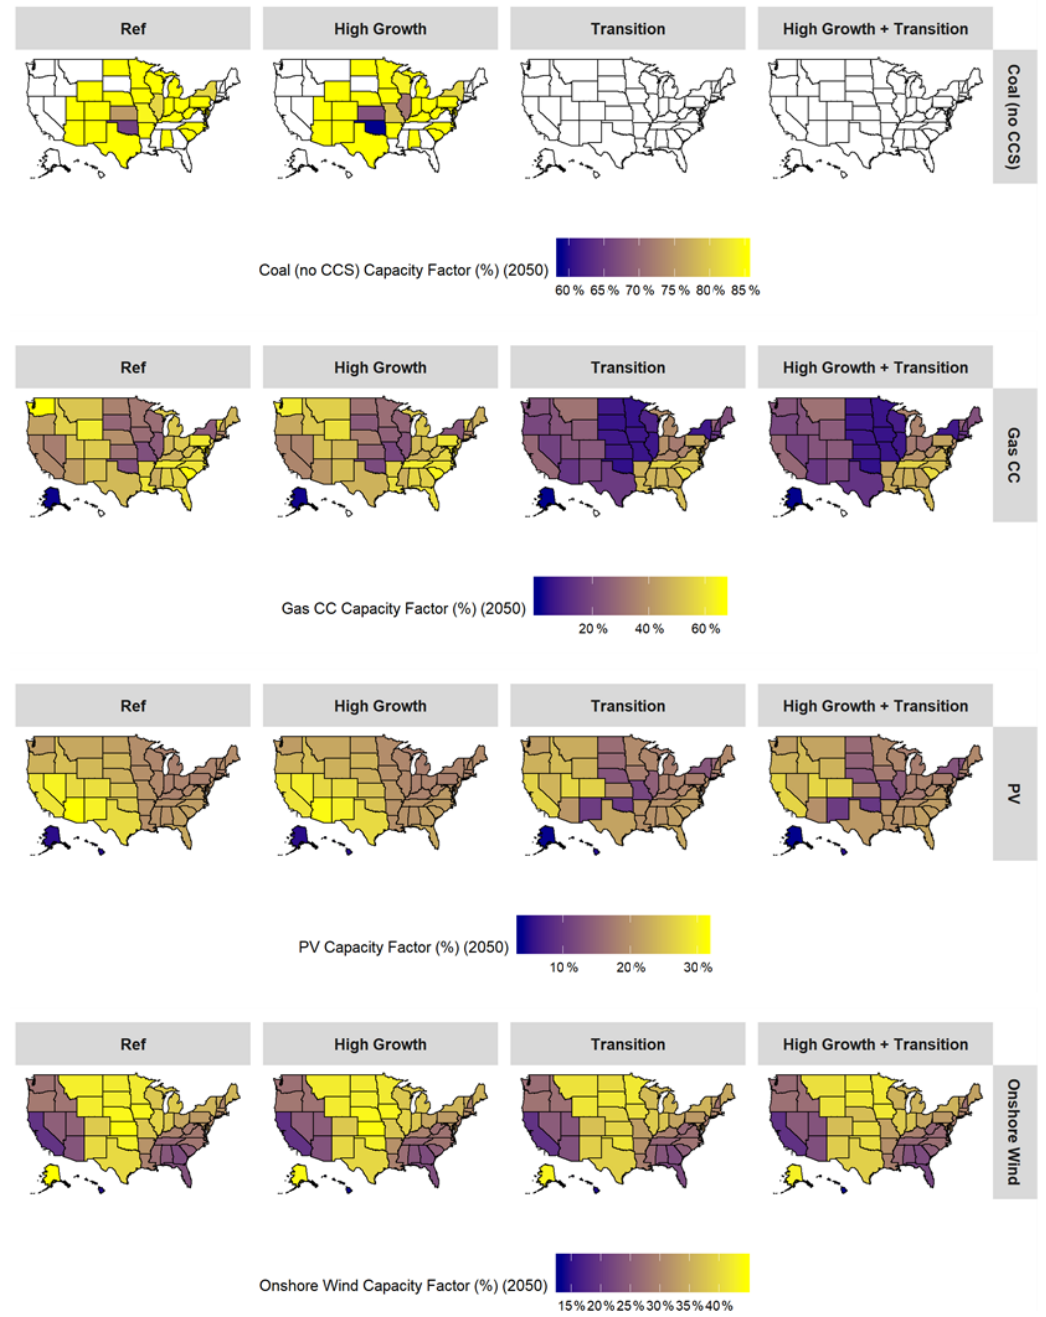
Figure 6. USA power sector capacity factor by scenario for select technologies in 2050. Note that color scales differ between technologies. No shading (white) indicates zero capacity in that state, period, and